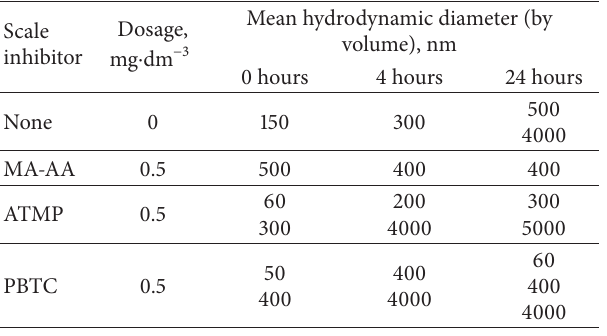
Table 5: Mean hydrodynamic diameter of calcium sulfate particles dependence on time at 25 ∘